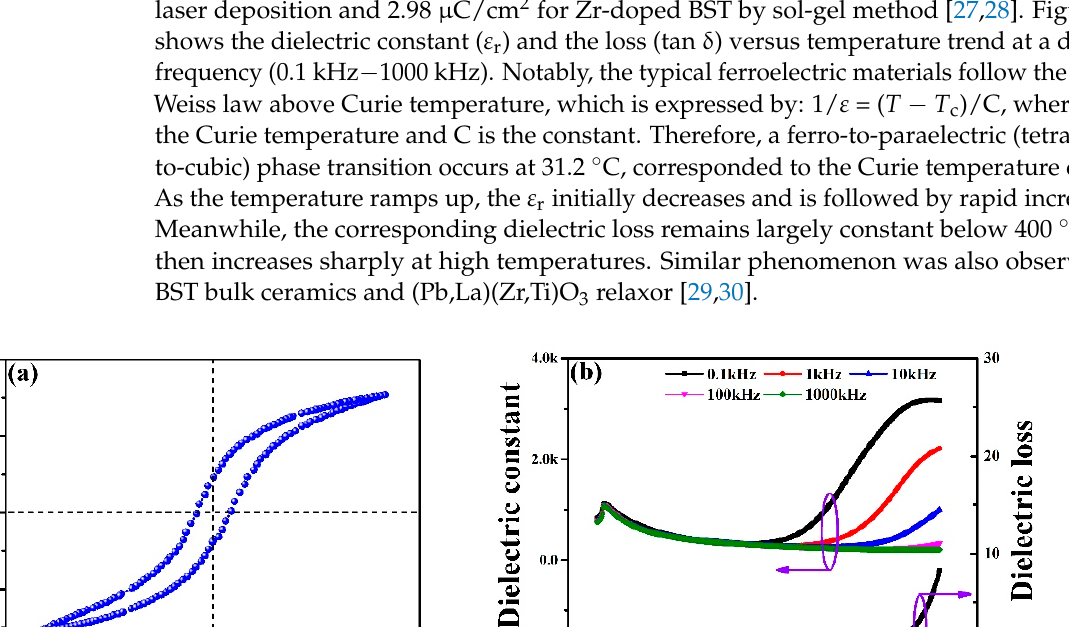
Figure 2. ( a ) Survey scanning of BST films. ( b – f ) High resolution XPS of C 1s, Ba 3d, Sr 3d, Ti 2p, and O 1s.